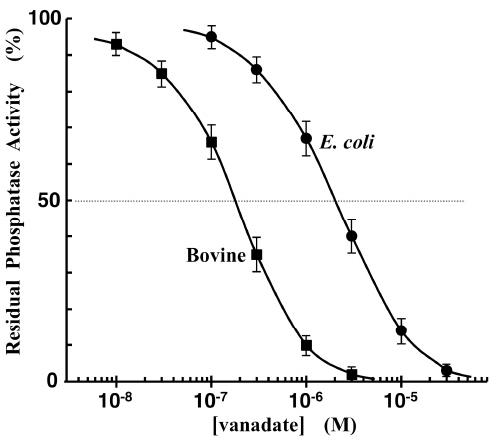
Figure 7. Inhibition curves of the AP reactions in the presence of dihydrogen orthovanadate ion (H 2 VO 4– ) at 25 °C. The ordinate represents the residual phosphatase activity ratio (%). The reaction mixture contained 5.0 µM TAMRA-Phos-tag, 2.5 µM pyrophosphate, 0.10 mM MgCl 2 , 0.10 M NaCl, and 10 mM Hepes-NaOH (pH 7.4). The amounts of bovine intestinal AP (closed squares) and E. coli AP (closed circles) were 0.05 units/mL and 0.02 units/mL,